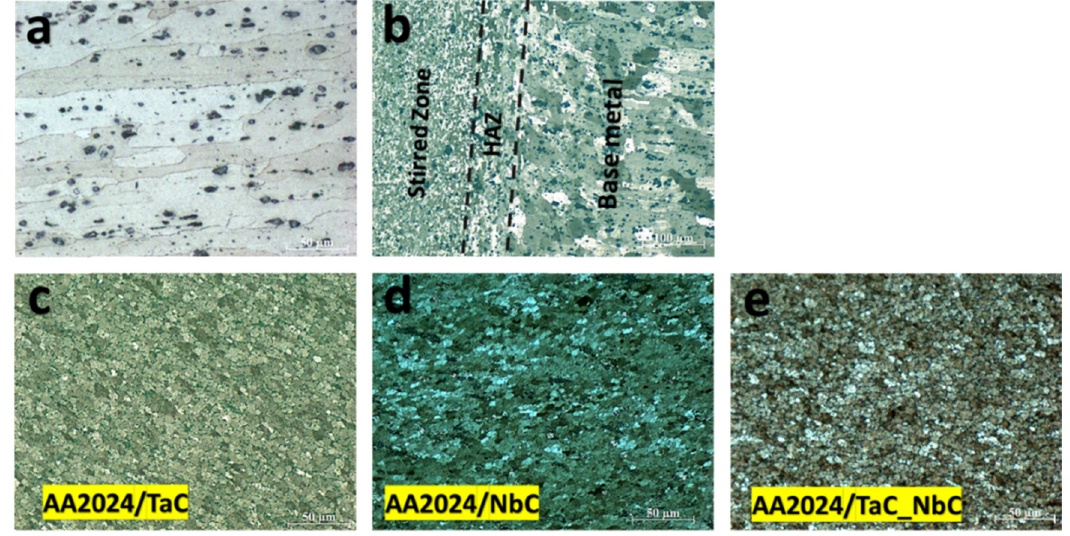
Figure 4: Optical microscope images of the ( a ) wrought AA2024, ( b ) orientation of the AA2024/TaC_NbC composite processed zone, and microstructure re fi nement distributions of the ( c ) AA2024/TaC and ( d ) AA2024/NbC monocomposites, and ( e ) AA2024/TaC_NbC hybrid composite.